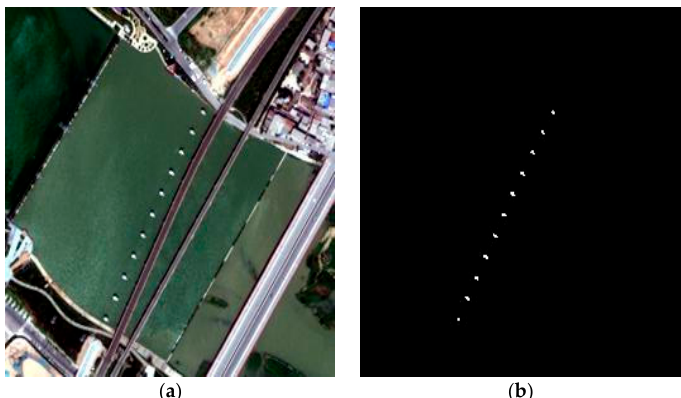
Figure 6. The image of the Chanba Area: ( a ) three band false color composite; and ( b ) reference data.